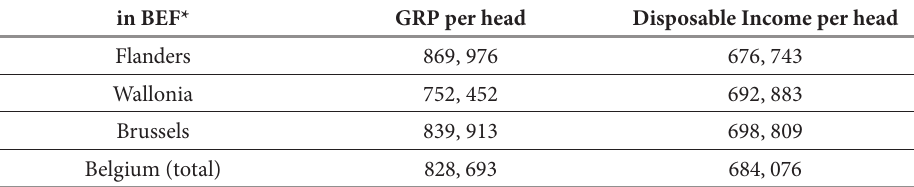
Table 2. Income Paradox in Belgium (1996) in